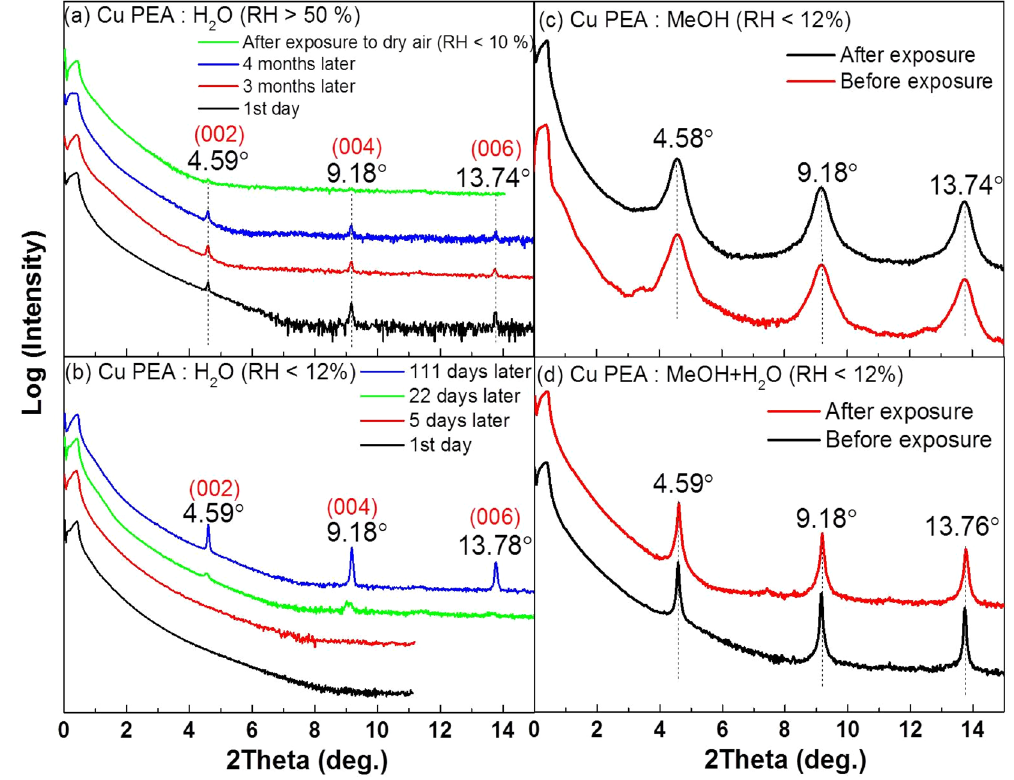
Figure 4. Time-dependent x-ray diffraction analysis of Cu-PEA thin films synthesized made from water solvent ( a ) at high RH over 50% ( b ) at low RH less than 12%. Note that x-ray diffraction measurement was repeated over that time periods that samples had been kept in desiccator with setting of RH less than 30% after synthesis. Cu-PEA thin films made from ( c ) MeOH solvent, ( d ) a mixture of MeOH and H 2 O solvents before and after exposure to dry air (RH < 12%) for a couple of